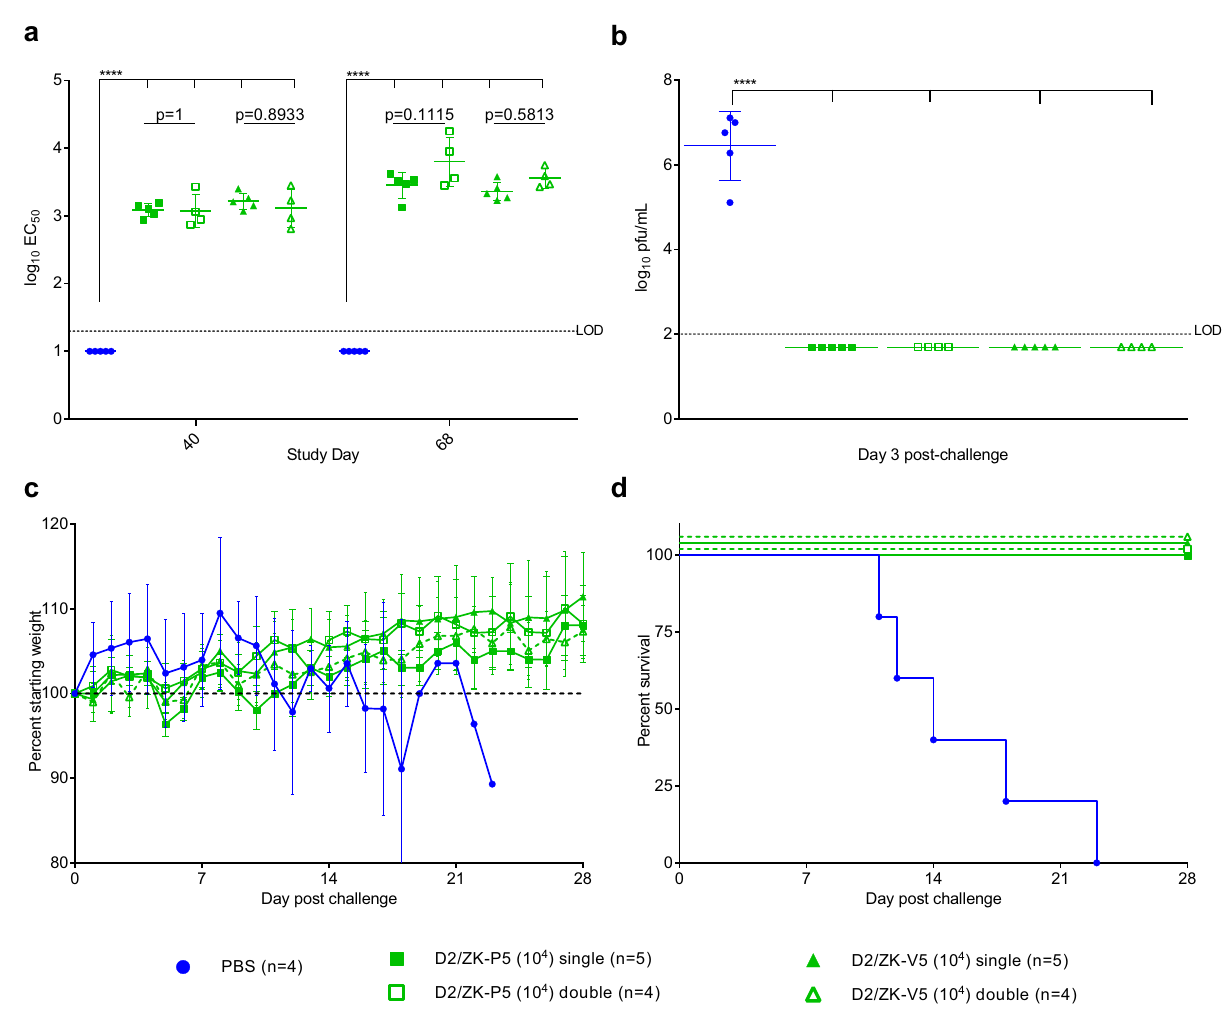
Fig. 6 Protective ef fi cacy and immunogenicity of single- or double-dose of D2/ZK-P5 and -V5 virus in AG129 mice. Separated groups of mice were immunized once (day 0) or twice (day 0 and 42), and challenged with 10 4 pfu of wt ZIKV on day 70. a NAb titers of immunized mice at 40 and 68 days after primary immunization. b Viremia after wt ZIKV challenge. c Weight changes after ZIKV challenge. d Kaplan – Meyer survival curves after lethal ZIKV challenge. Horizontal bars (in a and b ) represent the group GMT, error bars represent SD. Negative samples are plotted at the half value of the assay LOD and have been included in determination of GMTs and statistical analysis (one-way ANOVA with Tukey ’ s test to correct multiple comparisons). **** p < 0.0001, Not signi fi cant: p > 0.05 (exact p values provided in graph). Number ( n ) of mice used in each group is indicated in the symbol